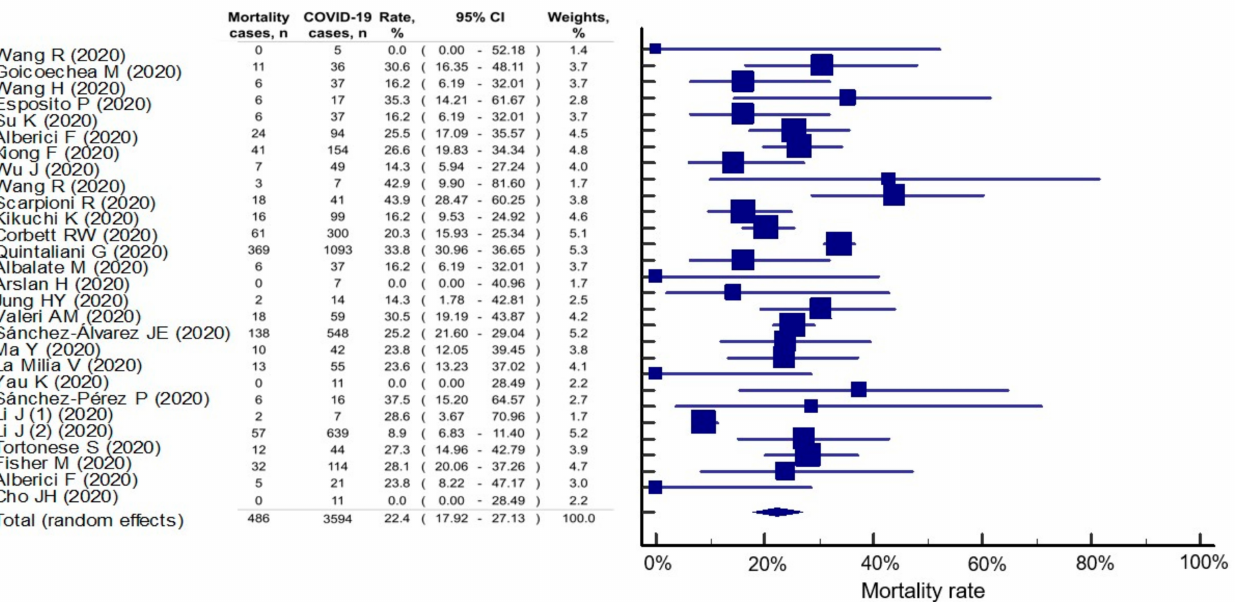
Figure 4. Mortality rate in hemodialysis patients with COVID-19 infection. The study of Li J et al [13]. reported two independent cohorts that were analyzed separately for meta-analysis. The second cohort of Li J et al. reported mortality in 57 deaths from 639 COVID-19 cases (all cases showed feature of viral pneumonitis and 109 were further confirmed by nuclear acid testing). HD, hemodialysis; CI, confidential interval. HD, hemodialysis; CI, confidential interval.